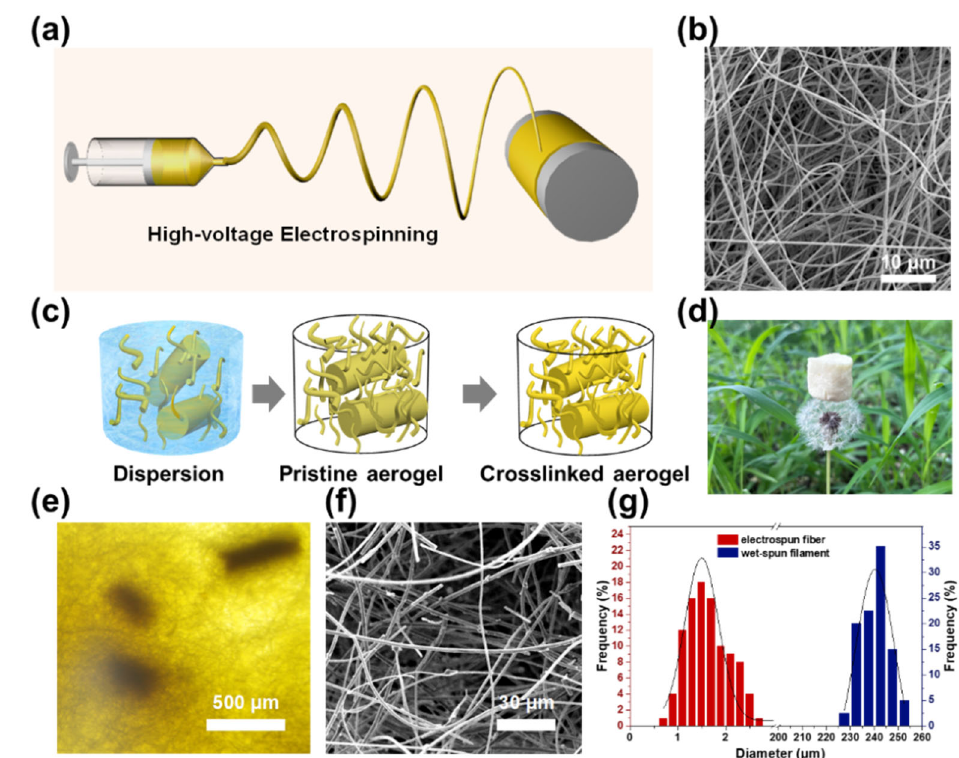
Figure 2. ( a ) The process of fabrication of PAI/BMI electrospun fiber. ( b ) The SEM images of PAI/BMI electrospun fibers. ( c ) The schematic diagram of PAI/PBMI aerogel preparation process. The PAI/PBMI aerogel ( d ) optical image and ( e ) SEM image. ( f ) Distribution of filaments and fibers within PAI/PBMI aerogel. ( g ) The diameter distribution of the PAI/PBMI aerogels.